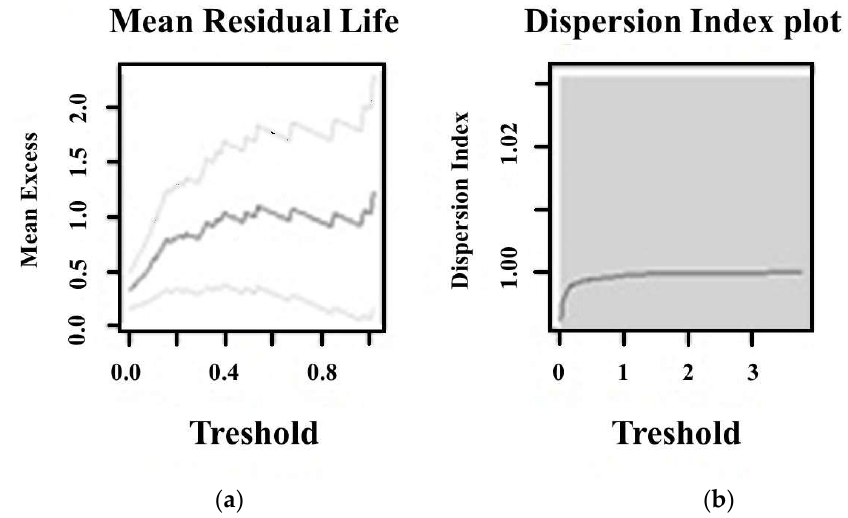
Figure 4. Example of the selection of threshold ( a ) MRL Plot and ( b ) Dispersion Index Plot in Pápa between 1991–2016. The grey lines in the MRL Plot are the minimum and maximum values of the 95% confidence interval.